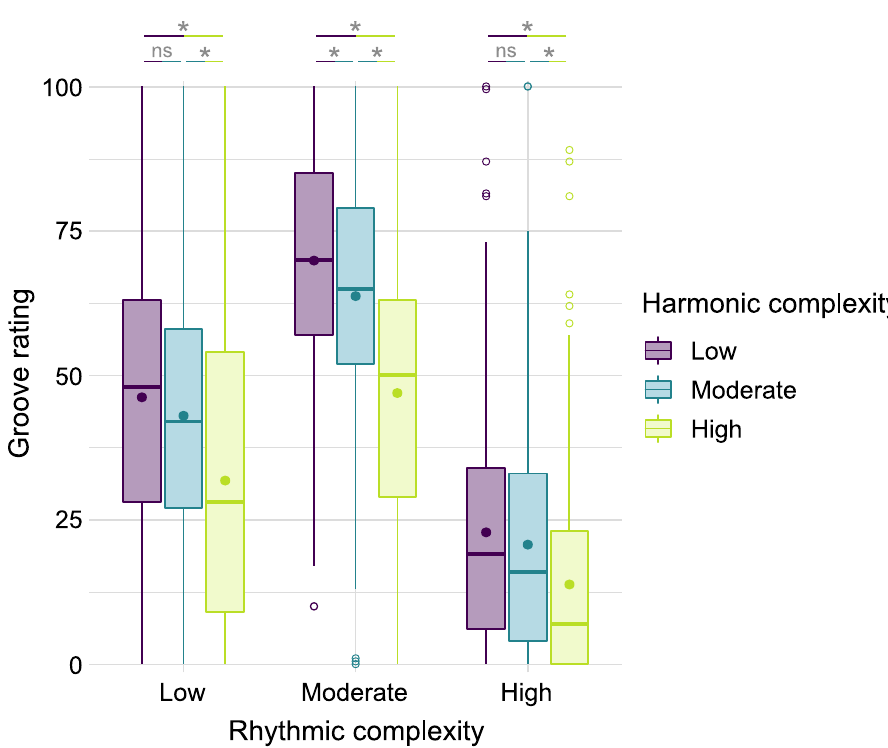
Fig 2. Groove ratings as a function of rhythmic and harmonic complexity. Dots represent mean groove ratings. Boxplots: The centerline represents the median. The lower and upper ends of the boxes correspond to the first and third quartiles. Whiskers represent lowest and highest values within 1.5 × interquartile range (IQR) from the lower and upper quartiles, respectively. Circles represent values outside 1.5 × IQR. ns = nonsignificant , � p < .001 .